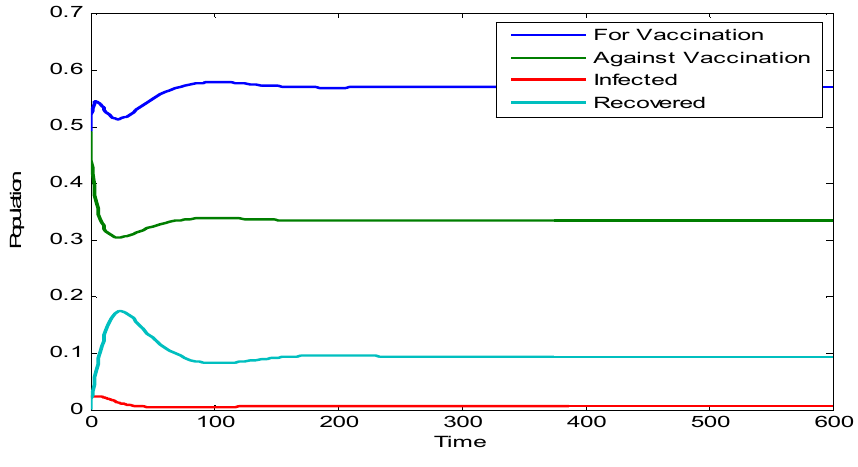
Figure 1. Dynamics of the model.